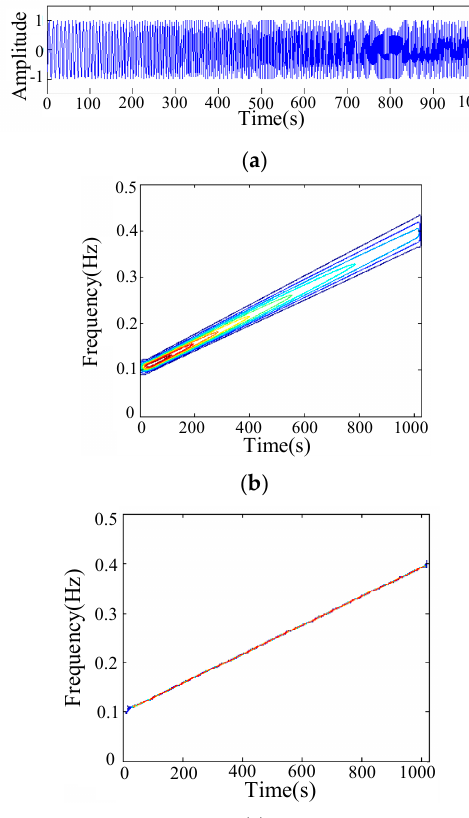
Figure 9. Simulation signal analysis. ( a ) Time waveform for a line modulation signal; ( b ) Wavelet scalogram for the line modulation signal; ( c ) Reassigned wavelet scalogram.